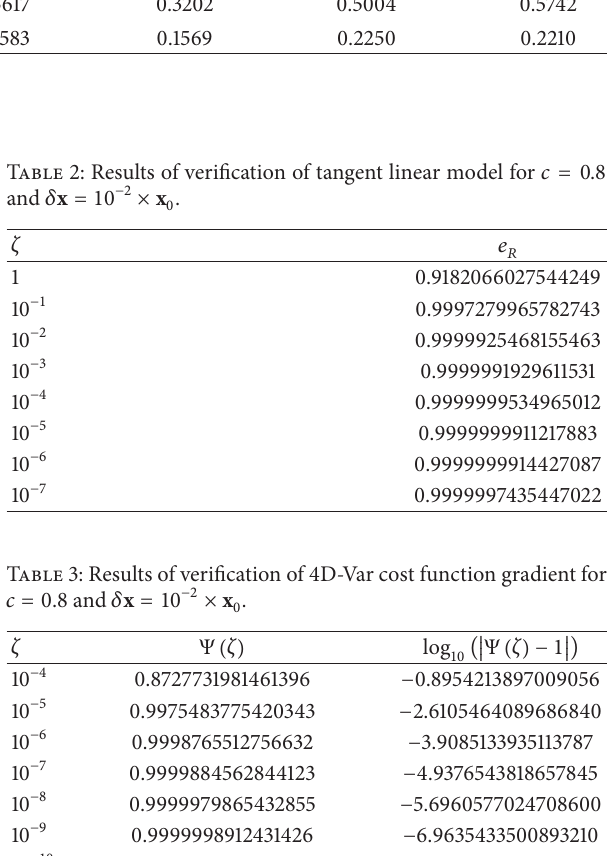
Table 2: Results of verification of tangent linear model for 𝑐 = 0.8